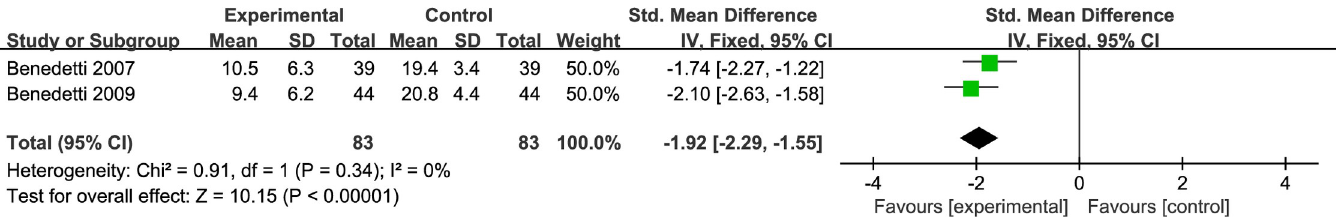
Fig 14. Forest plots with light intensities less than 5000lux.